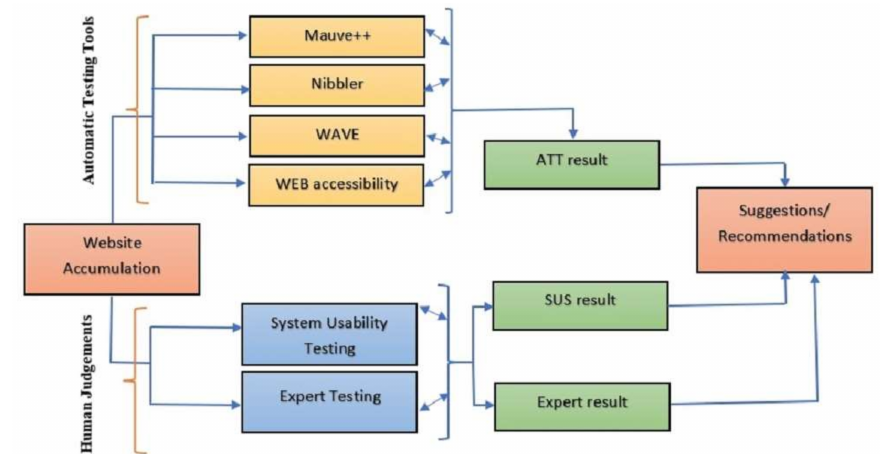
Figure 2. Workflow